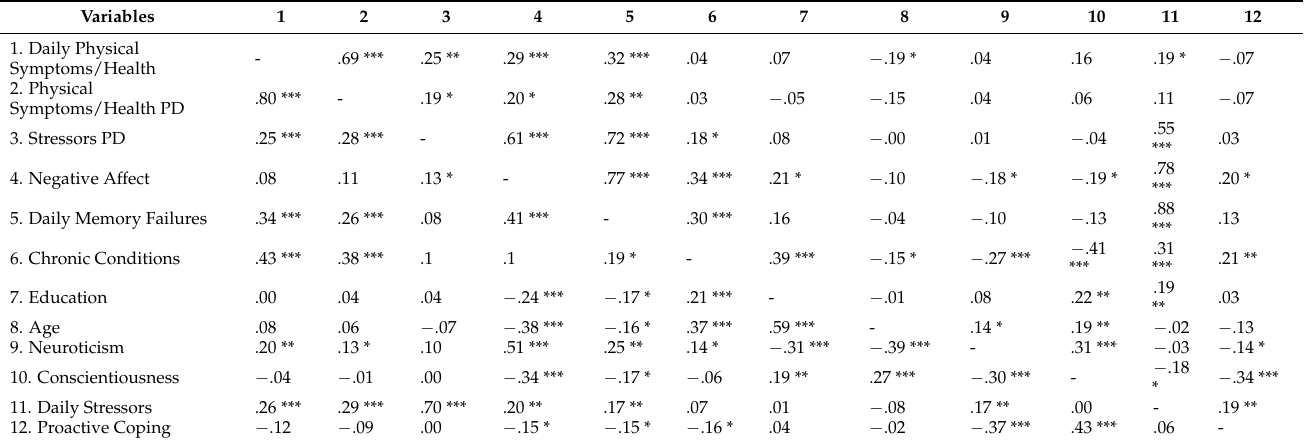
Table 2. Between-Person